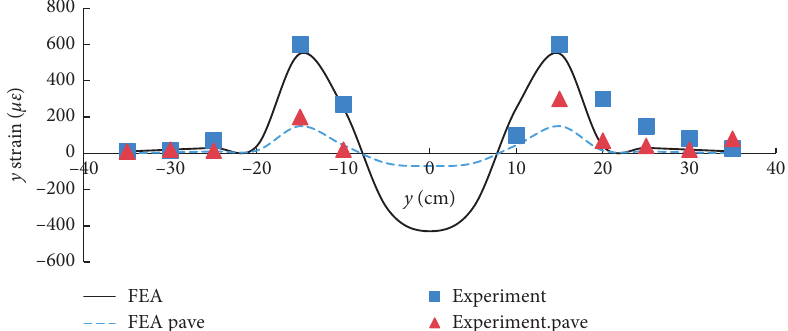
Figure 21: Strain at the transverse bridge section (i.e., X � 0 cm position) passing through the load center